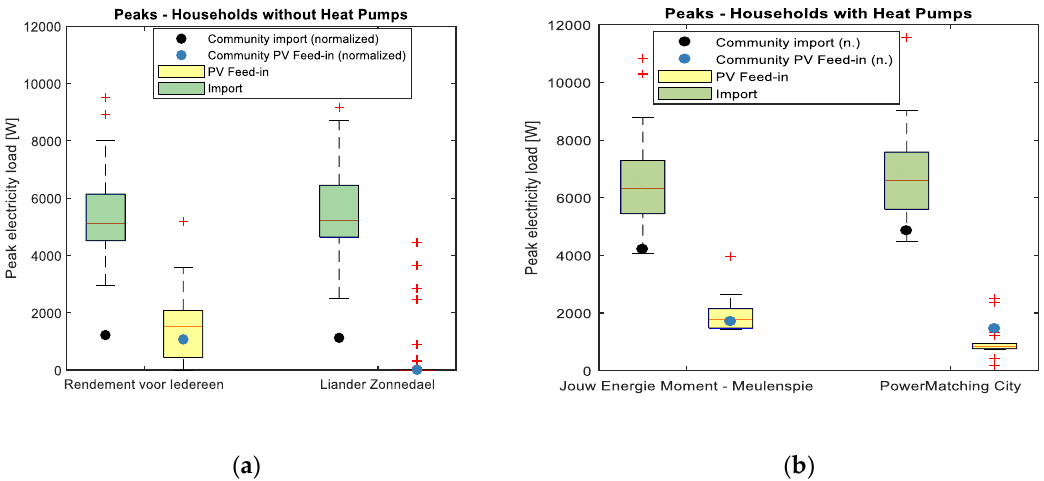
Figure 5. Boxplots of annually imported electricity from the grid and surplus of PV generated electricity (feed-in) to the grid, based on 15 min averages. (a) results for Rendement voor Iedereen pilot and Liander (without electrical heating), (b) results for Jouw Energie Moment-Meulenspie and Power Matching City (with electrical heating). For each box, the red line indicates the median, and the bottom and top edges of the box indicate the 25th and 75th percentiles, respectively. The whiskers extend to the most extreme data points without considering the outliers, and the outliers are plotted individually in red. The black dots represent the normalized import peak for the whole community, and the blue dot represents the normalized PV feed-in peak.